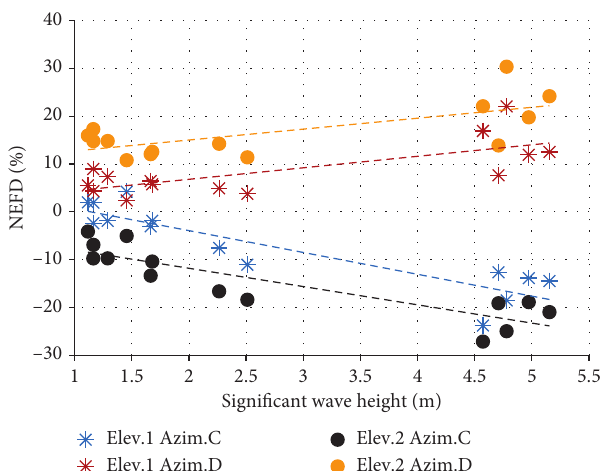
Figure 10: Normalized error of fatigue damage (NEFD) based on initial azimuth